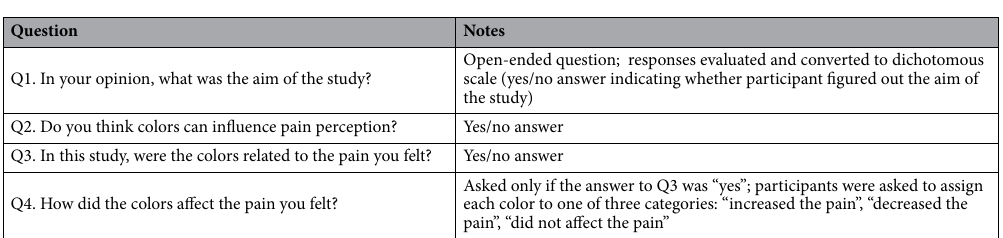
Table 5. End of study